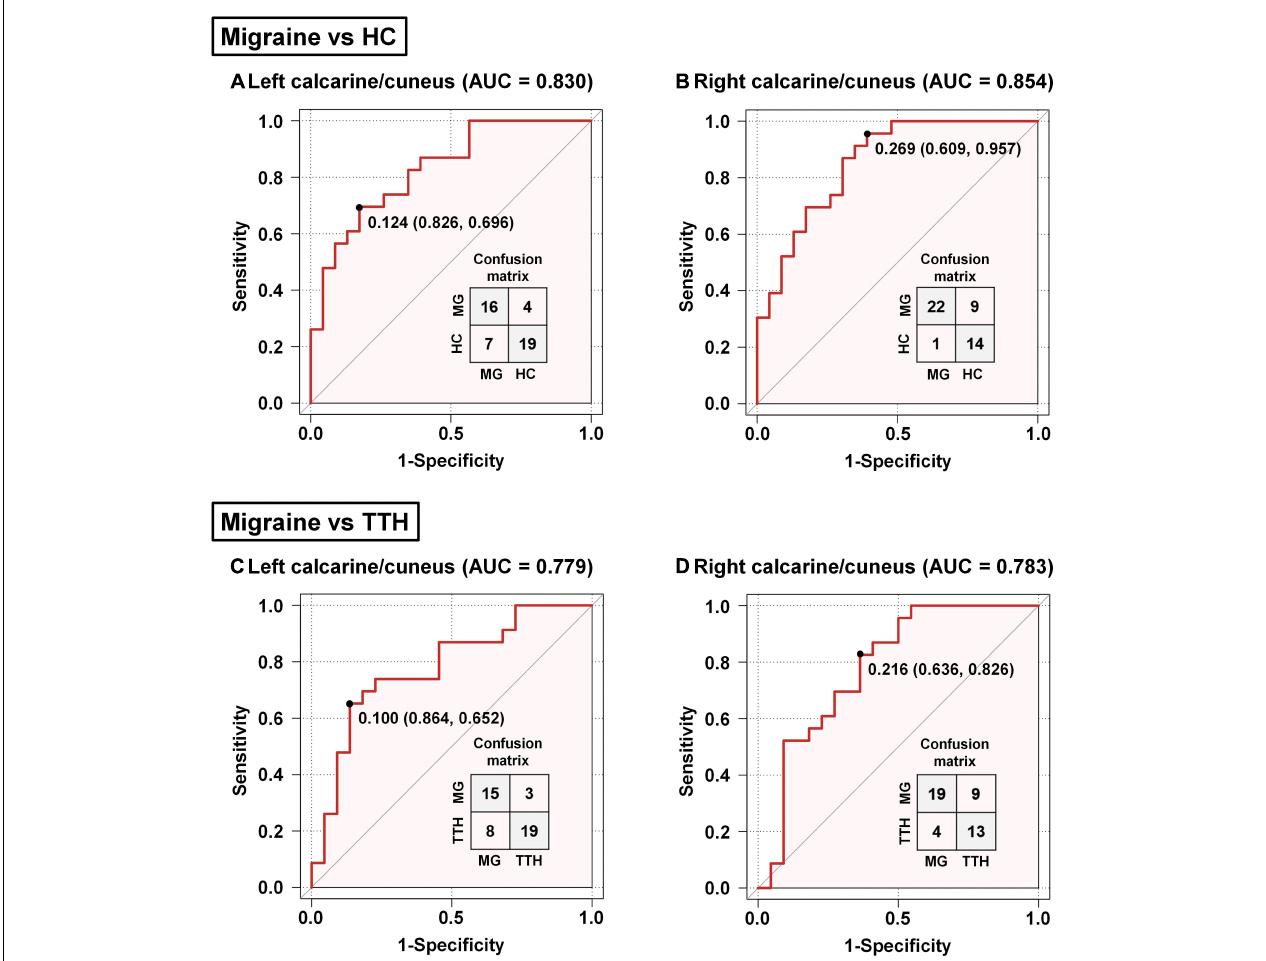
FIGURE 5 | Classification of migraineurs and non-migraineurs based on the rsFC alterations (seed: left hippocampus). Classification of migraineurs and HCs (A,B) ; classification of migraineurs and patients with TTH (C,D) . The point on each ROC curve represents the optimal cut-off (specificity and sensitivity). MG, migraine; HC, healthy controls; TTH, tension-type headache; ROC, receiver operating characteristic; AUC, area under the